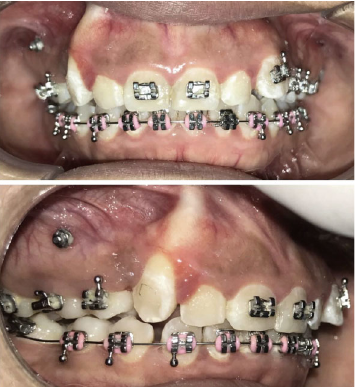
Figure 3: Extreme gingival thinning over the root of